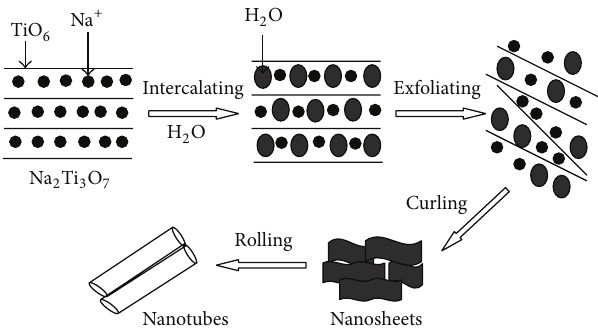
Figure 3: Exfoliating-rolling model of nanotube formation from the layered Na 2 Ti 3 O 7 particles by a soft chemical process.